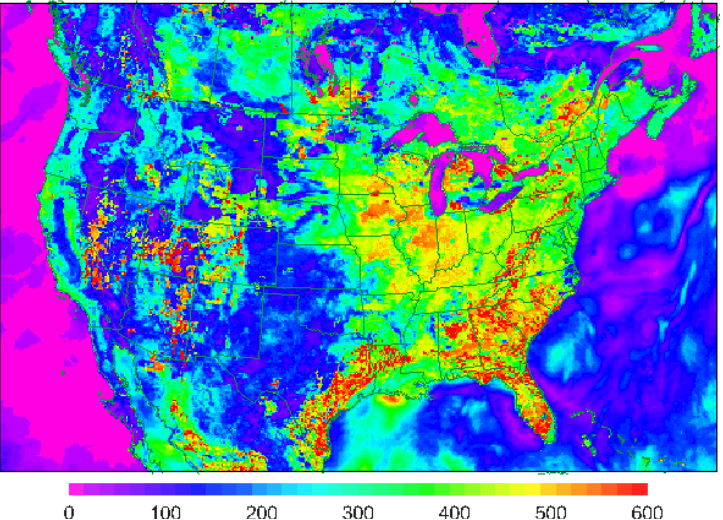
Figure 7. Latent heat flux (W/m 2 ) from a 12 km grid resolution WRF simulation on 25 July 2006 at 19